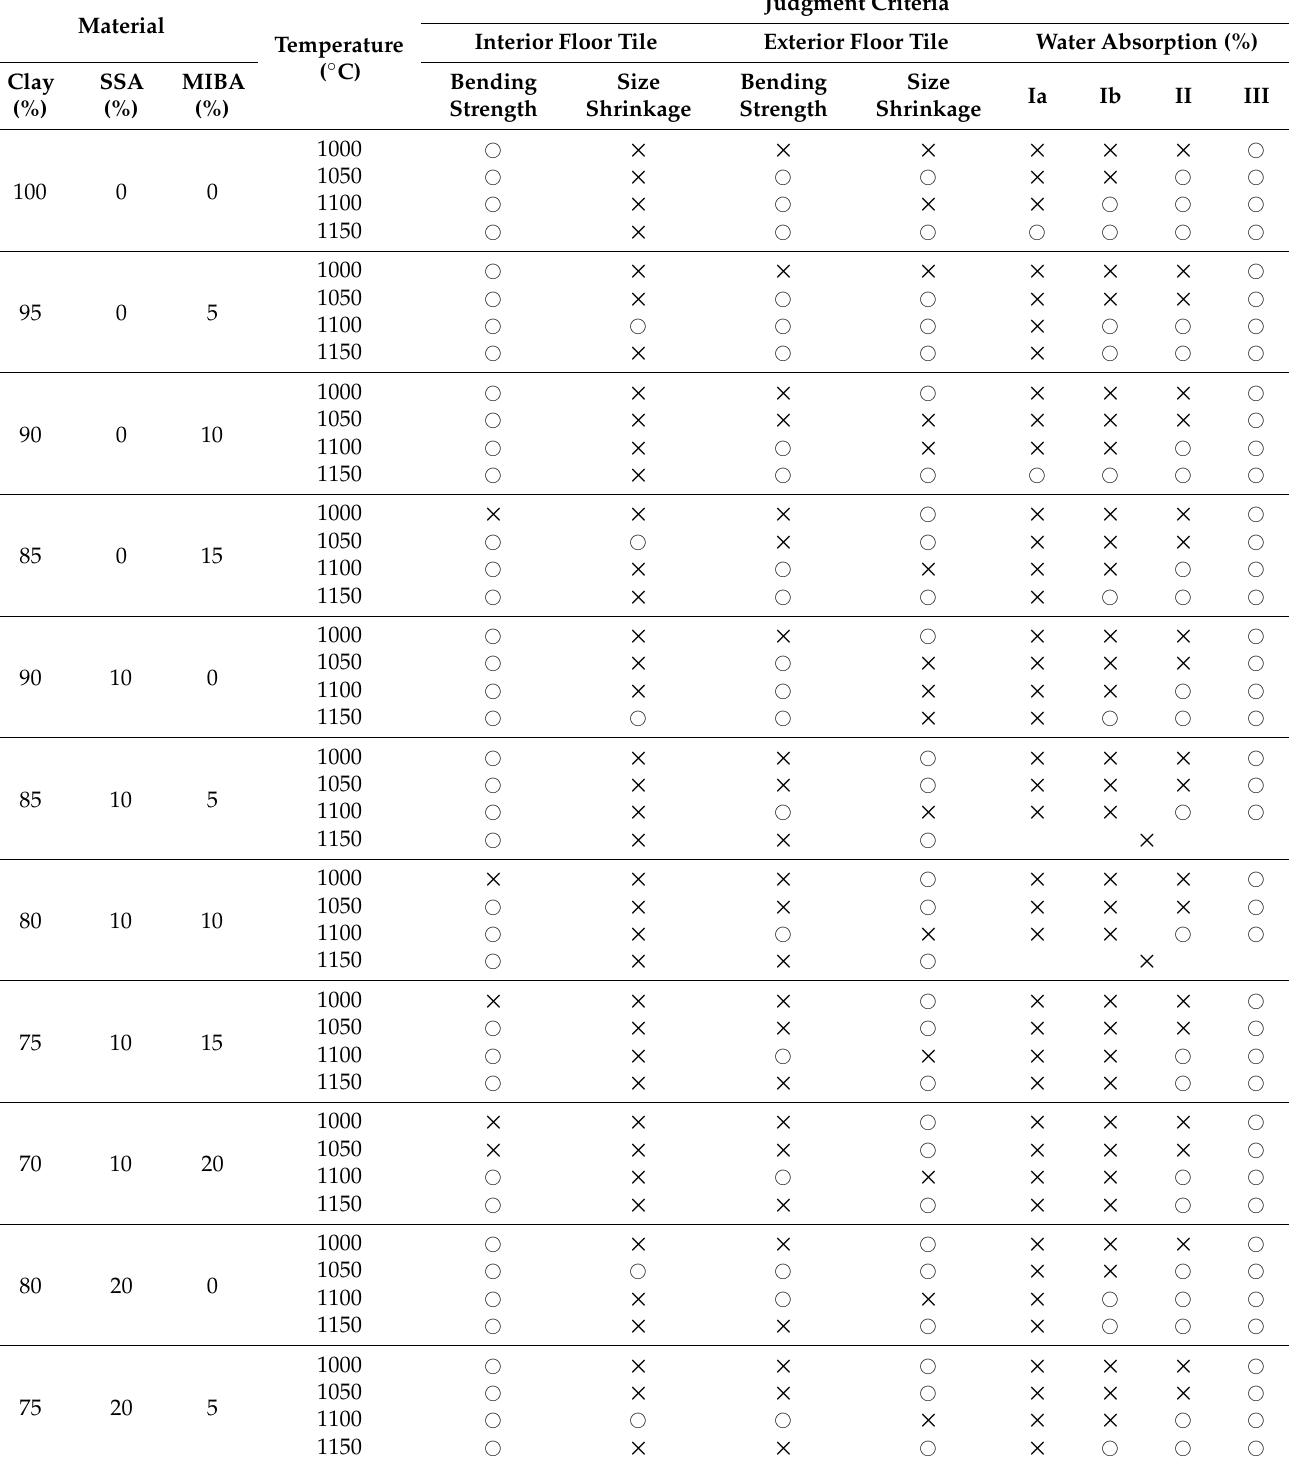
Table 5 summarizes the quality classification for ceramic floor tiles with various MIBA and SSA mixes. Table 5. Quality compliance